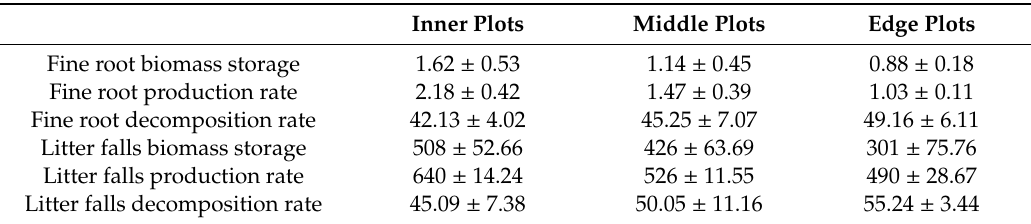
Table 2. Biomass (Mg / ha), production (Mg / ha · y), and decomposition (% / y) of fine roots and litter falls within plots from forest interiors to edges.